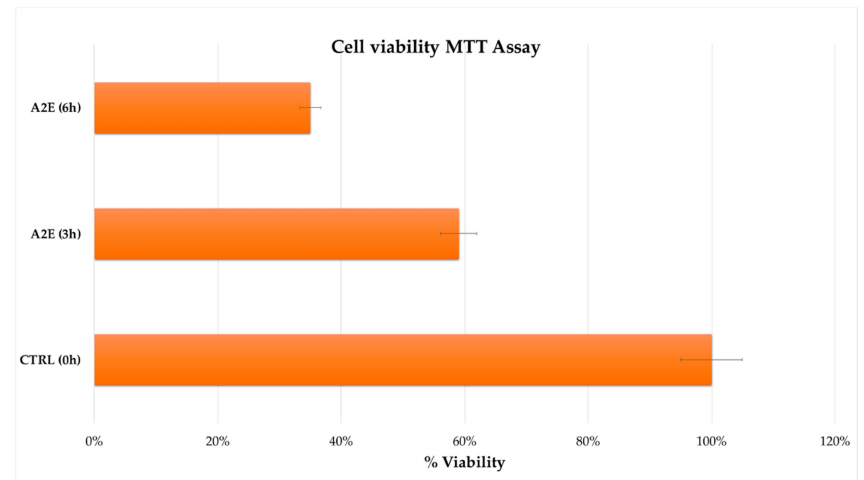
Figure 3. Cell viability from methylthiazolyldiphenyl-tetrazolium bromide (MTT) assay. Retinal pigment epithelium (RPE) cell survival percentage is expressed as mean of replicates ± standard error of mean, considering three replicates for each independent experiment ( n = 3). Multiple t -tests were performed for statistical comparisons ( p < 0.05). Results were assessed at both treatment considered time points (3 h and 6 h) compared to time zero untreated